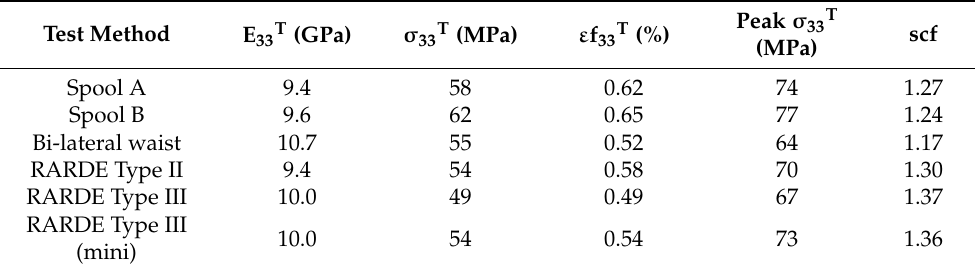
Table 8. Through-thickness (T-T) tensile properties predicted from finite element analyses for direct geometries.